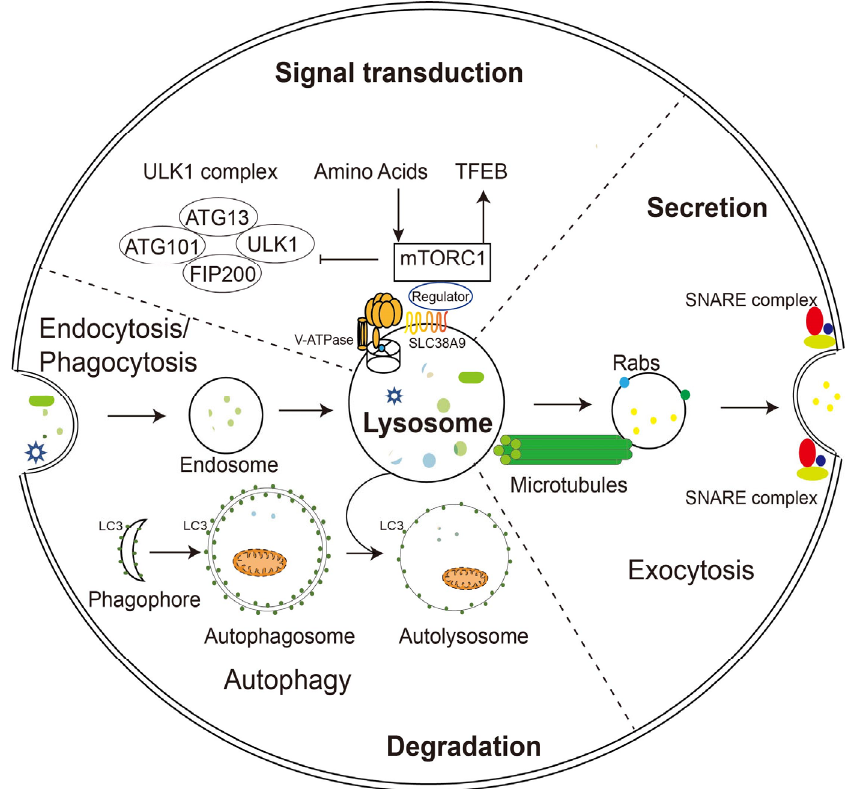
Figure 1. Schematic illustration of lysosomal functions. Lysosomes play a key role in endocyto- sis/phagocytosis, degradation, exocytosis, and signaling. Nutrients or foreign substances absorbed by endocytosis/phagocytosis enter the cytoplasm through the endosomal/lysosomal pathway. V‐ATPase and SLC38A9 on the lysosomal membrane regulate nutrient signaling, TFEB, and autophagy mechanisms by interacting with mTORC1. During phagocytosis, lysosomes move along microtubules and fuse with the plasma membrane with the help of Rabs and SNARE complexes.